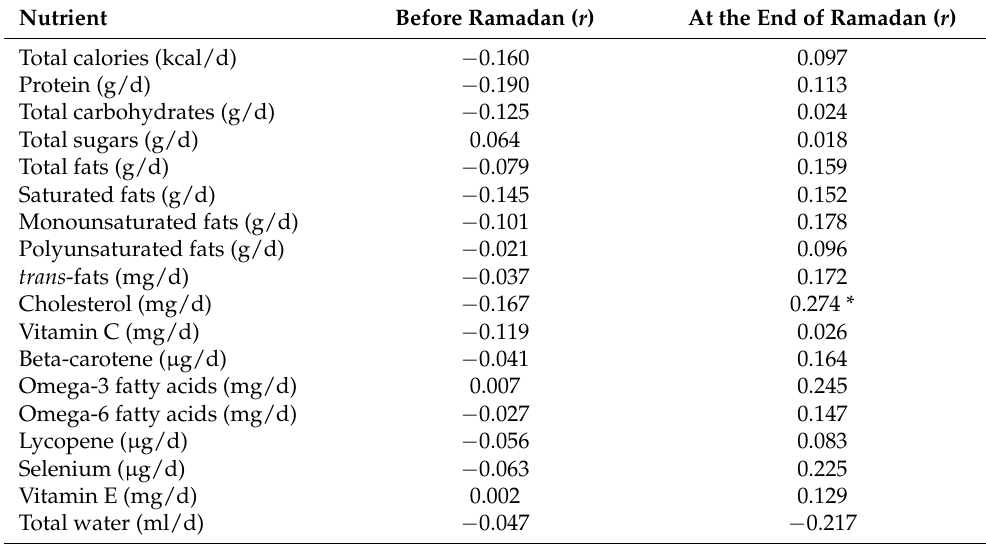
Table 5. Correlations between PCSK9 and different nutrients before and at the end of Ramadan fasting. Nutrient Before Ramadan ( r )